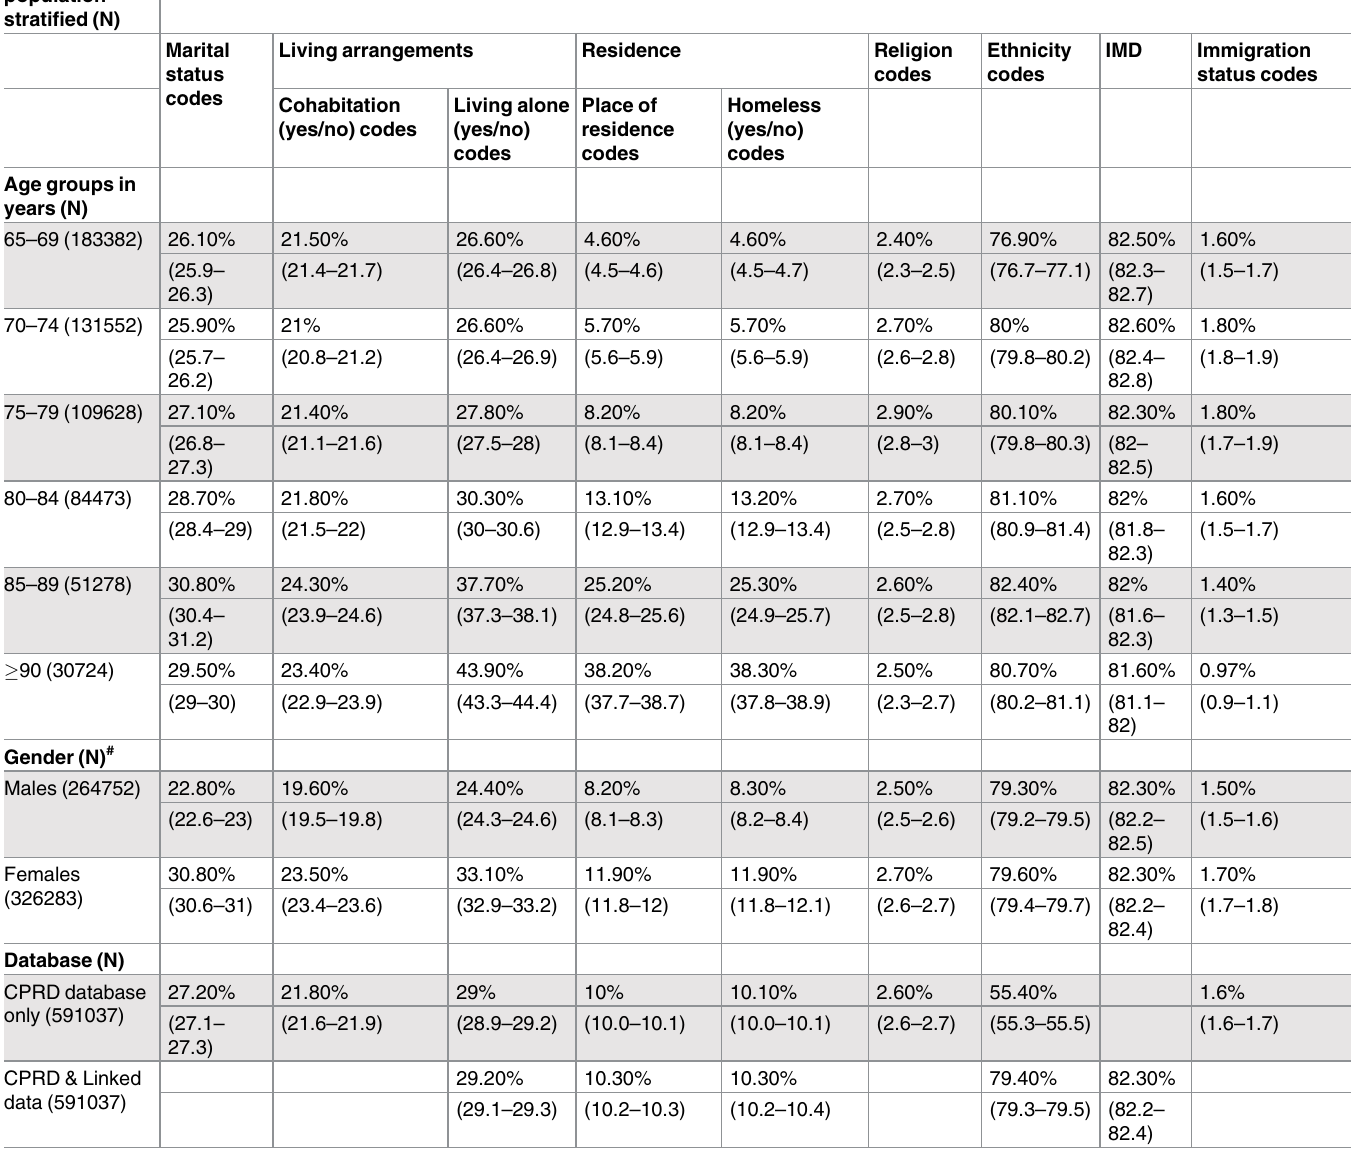
Table 1. Proportion of individuals with information on social factors available in Clinical Practice ResearchDatalink and Hospital Episodes Statis- tics: Age, sex and database distribution (N = 591037). Study population stratified